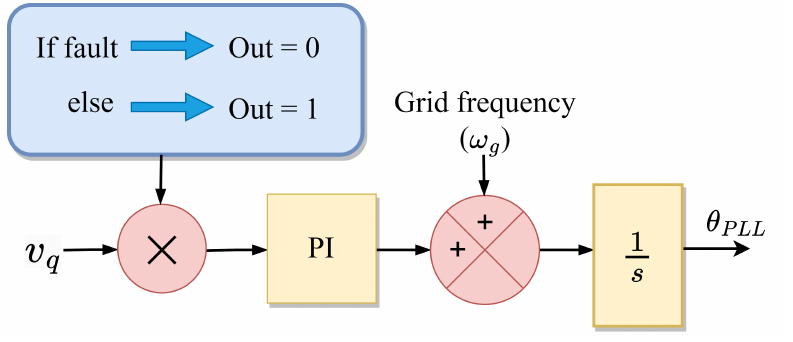
Figure 14. Approach 1 [69,109].